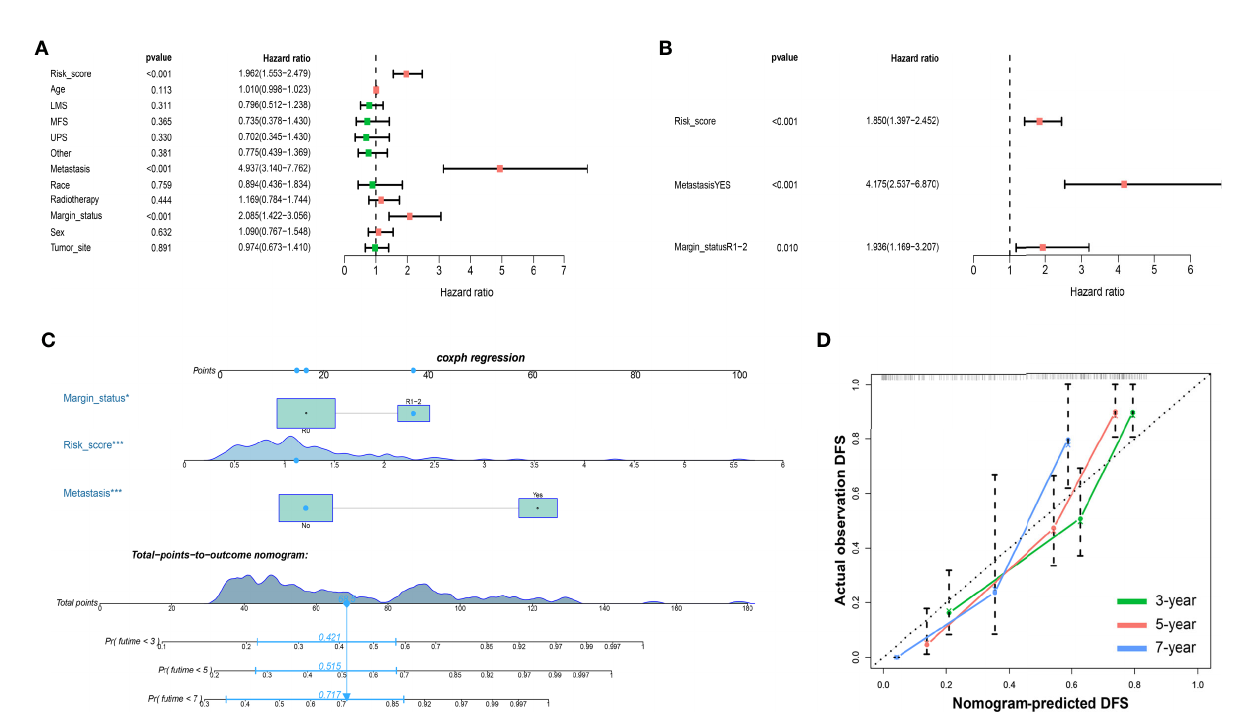
FIGURE 7 | Nomograms based on DFS-related IMRGs for osteosarcoma patients. (A) Univariate Cox analysis of DFS-related variables. (B) Multivariate Cox analysis of DFS-related variables. (C) Establish a nomogram to predict the DFS of patients. (D) The calibration curve shows that using a nomogram to predict DFS is highly consistent with actual DFS. DFS, disease-free survival; IMRGs, iron metabolism-related